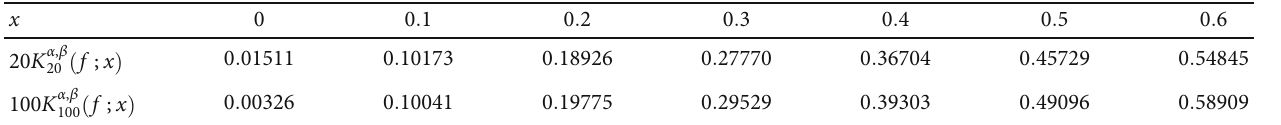
; x Þ and 100 K α , β ; x Þ at x = 0,0 : 1,0 : 2, ⋯ , 1 20 ð f 100 ð f